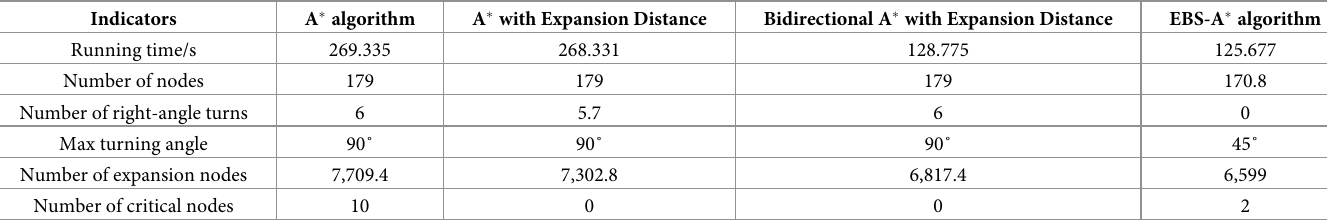
Table 4. Average simulation results of four algorithms on randomized 100 × 100